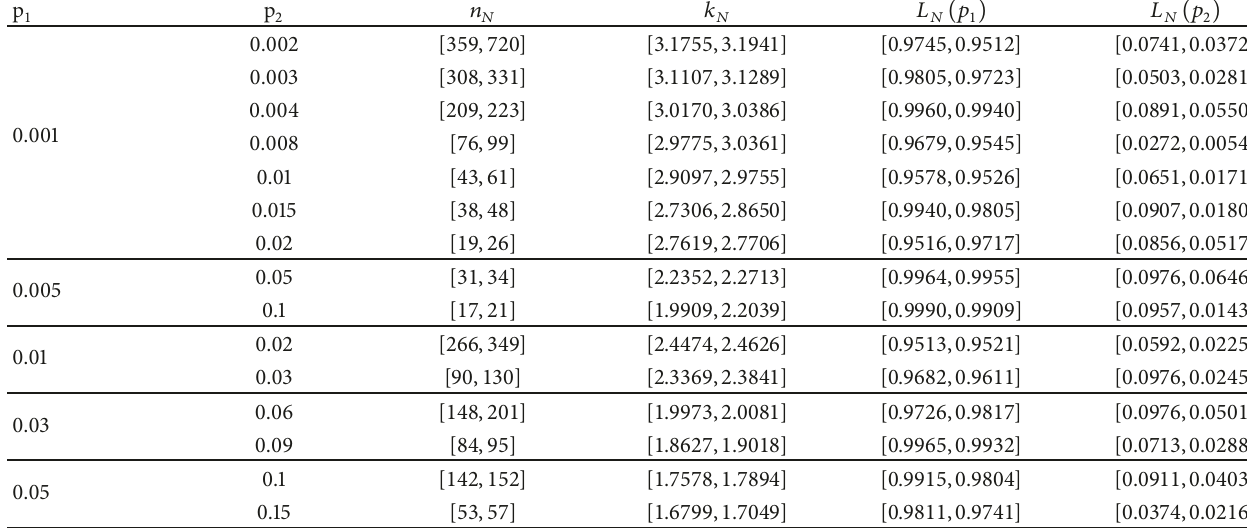
Table 1: The plan parameters when 𝛼 = 0.05 , 𝛽 =0.10, 𝑟 =2.